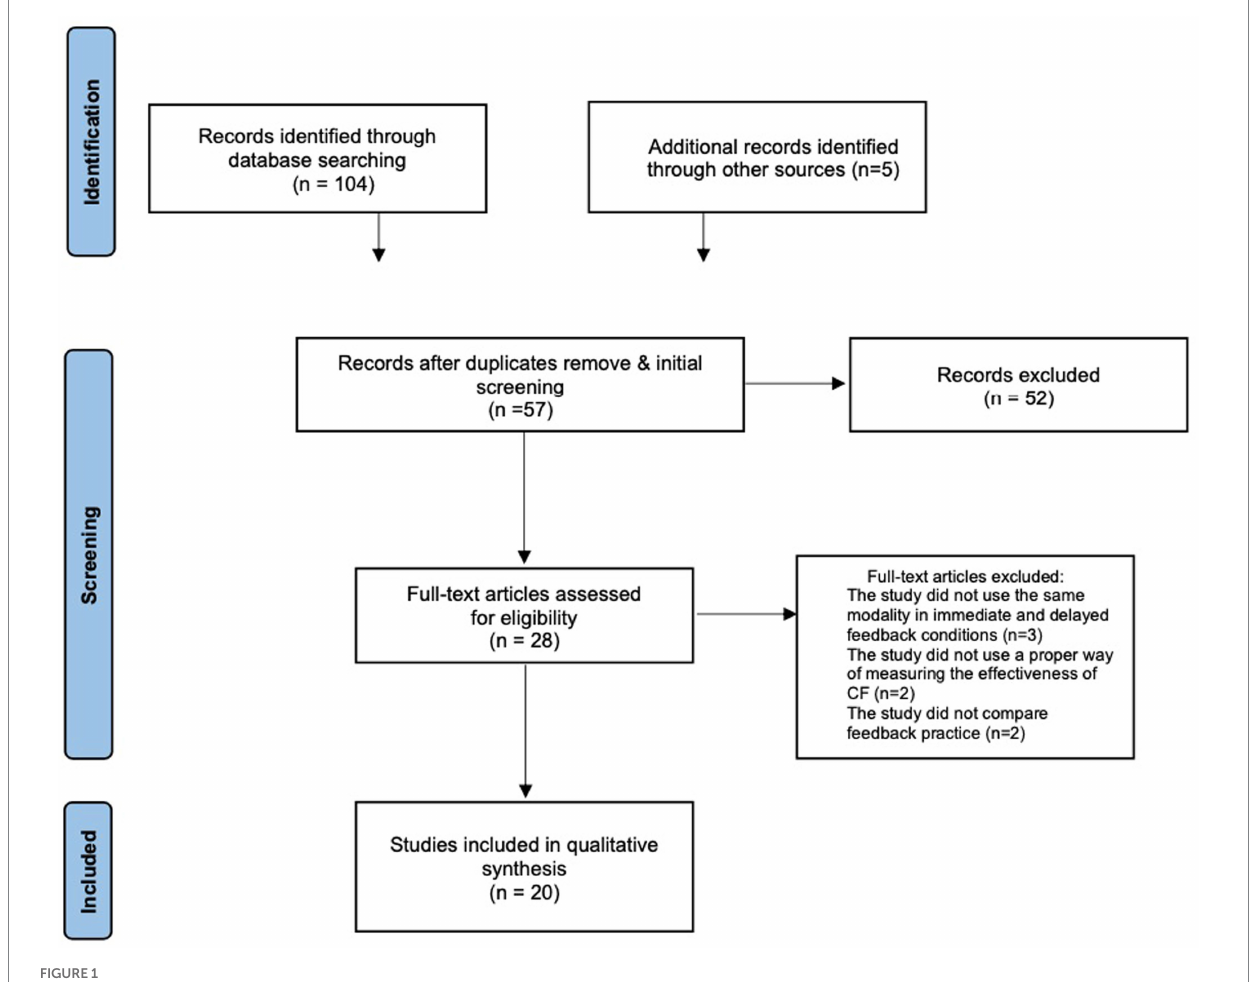
FIGURE 1 PRISMA flow chart of study